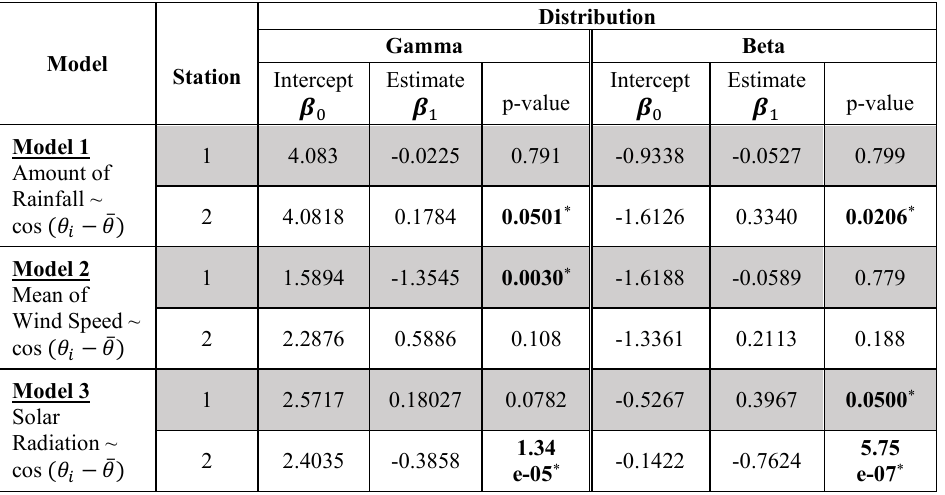
Table 3. Comparison of the parameter of regression models for Station 1: Bayan Lepas and Station 2: Muadzam